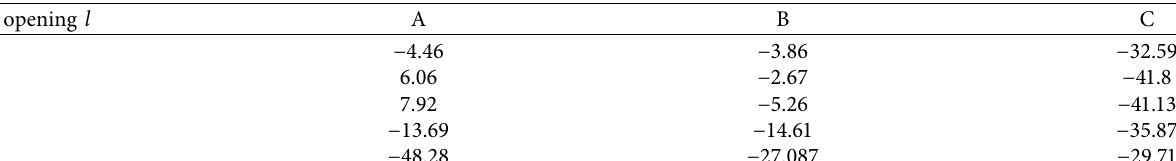
Table 3: Relationship between fracture inclination and fitting parameters.